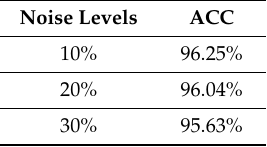
Table 8. Results of compound bearing fault diagnosis in various noise